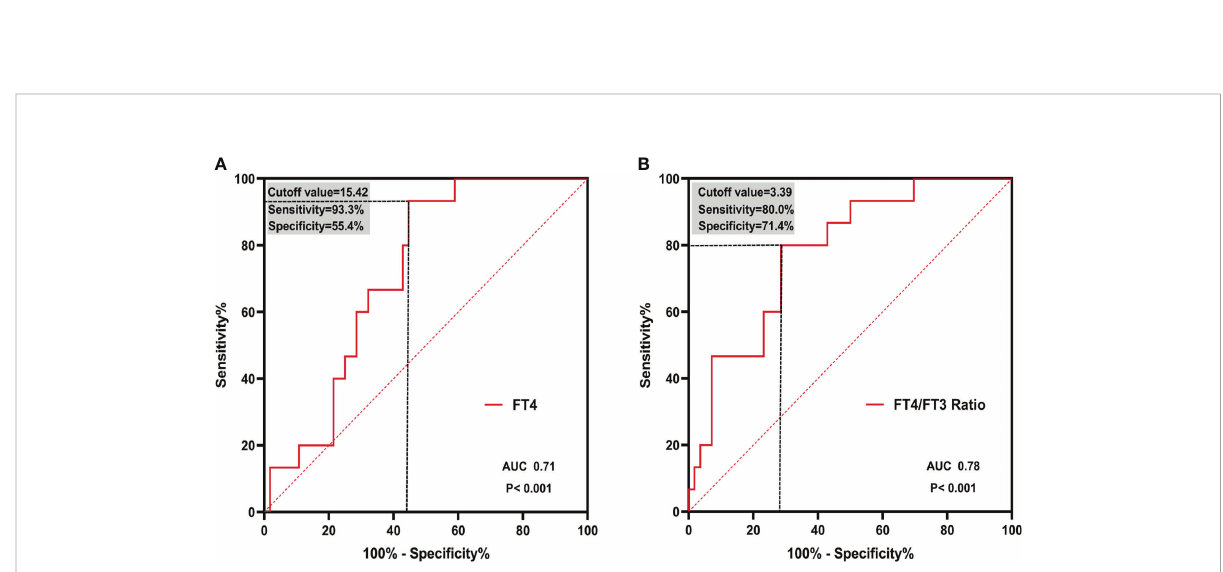
FIGURE 5 ROC curves of (A) FT4 and (B) FT4/FT3 ratio in predicting CMD. Cutoff value and corresponding sensitivity and speci fi city are shown. ROC, receiver operating characteristic; AUC, area under the